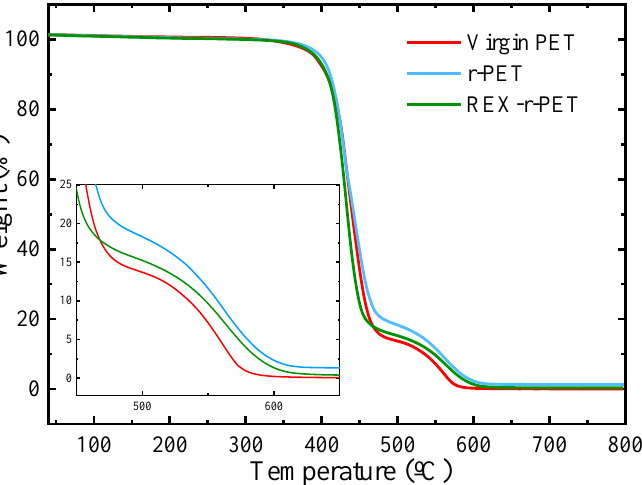
Figure 1. TGA traces of the indicated the PET samples recorded under air atmosphere, including an enlarged area at the 450–650 °C temperature range. enlarged area at the 450–650 ◦ C temperature range. Table 2. Thermal parameters obtained by